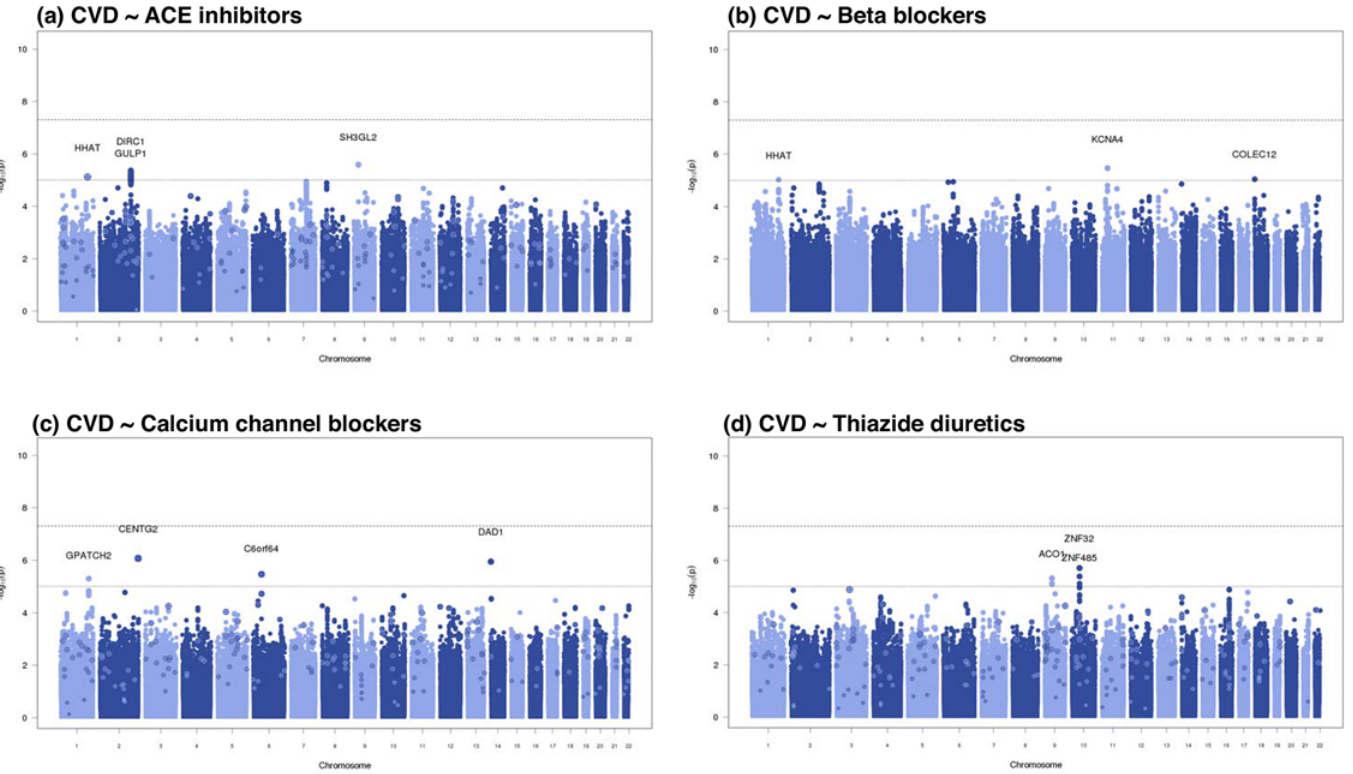
Fig 1. Plots show the individual interaction p-values based on Stage I (indicated as solid dots) or Stage I + Stage II meta-analysis (indicated as outlined dots with “ + ” symbol) against their genomic position for the combined cardiovascular disease (CVD) outcome for the four antihypertensive medication exposures: (a) Angiotensin-converting enzyme (ACE) inhibitors, (b) Beta-blockers, (c) Calcium Channel Blockers, and (d) Thiazide Diuretics. Within each chromosome, shown on the x-axis, the results are plotted left to right from the p-terminal end. The nearest genes are indicated for variants with an interaction p-value less than 1×10 − 5 in the